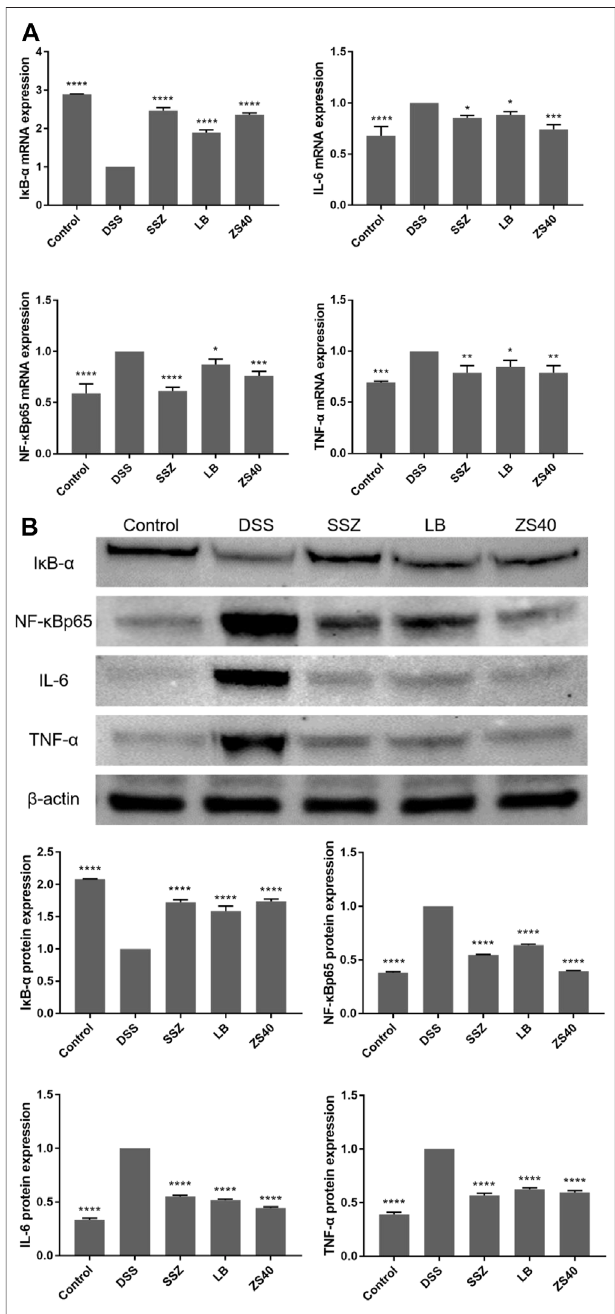
FIGURE6| ThemRNAandproteinexpressionlevelsofI κ B- α ,NF- κ B,IL- 6 and NF- κ B inhibitor- α (I κ B- α ) in colon of mice. (A) mRNA expression, (B) protein expression. Control group (cid:2) gavage with saline, DSS group (cid:2) 3% dextran sulfate sodium, SSZ group (cid:2) 500 mg/kg body weight (b.w.) salicylazosulfapyridine treatment dose, LB group (cid:2) 1.0 × 10 9 CFU/kg body weight (b.w.) L. bulgaricus treatment dose, ZS40 group (cid:2) 1.0 × 10 9 CFU/kg bodyweight(b.w.) L.fermentum ZS40treatmentdose.Dataareexpressedas mean ± SD; * p < 0.05, ** p < 0.01, *** p < 0.001, **** p < 0.0001compared with the DSS group.